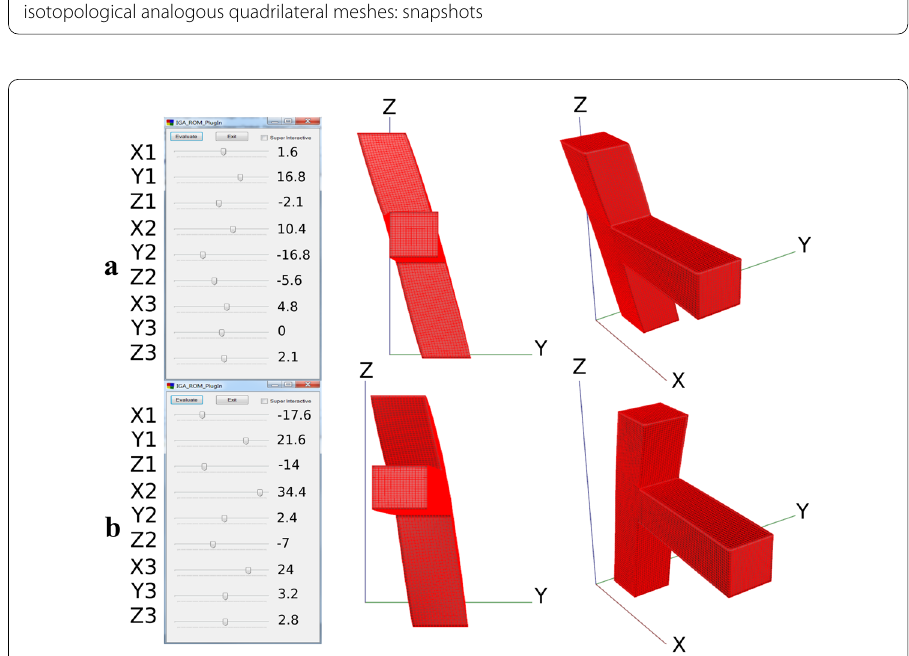
Fig. 15 Real-time data-based model. Geometry is evaluated from the built reduced order model. Row ( a ) left to right: parameters, right view and perspective. Row ( b ) left to right: parameters, right view and perspective for different